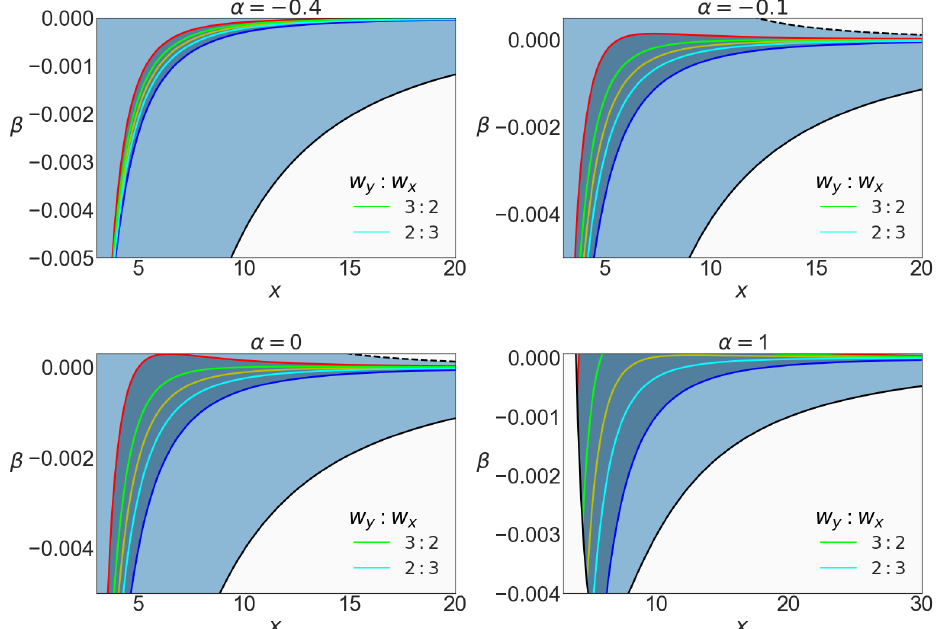
Figure 9. The light blue area depicts the region of existence of the circular orbits. This region is bounded by the thick black curve ( 2 S − x = 0 ) and the dashed line ( S = 0 ) . The blue-gray region shows the stability of the orbit with respect to vertical and radial perturbations. This region is bounded by the blue ( w 2 y = 0) and the red ( w 2 x = 0) curves. The lime curve shows the resonance w y = 3 and the light cyan curve, shows the resonance w y w x 2